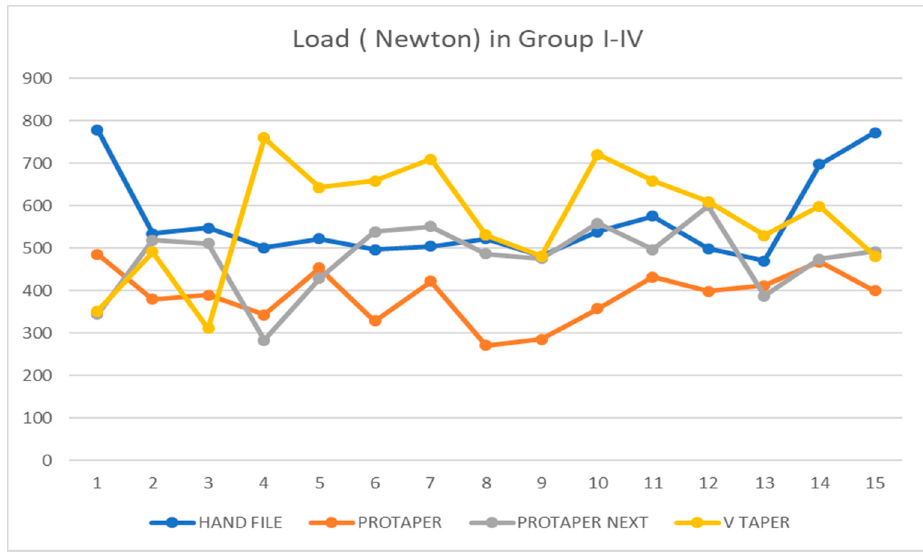
Figure 3. Graphical representation of pattern of load distribution in different groups.